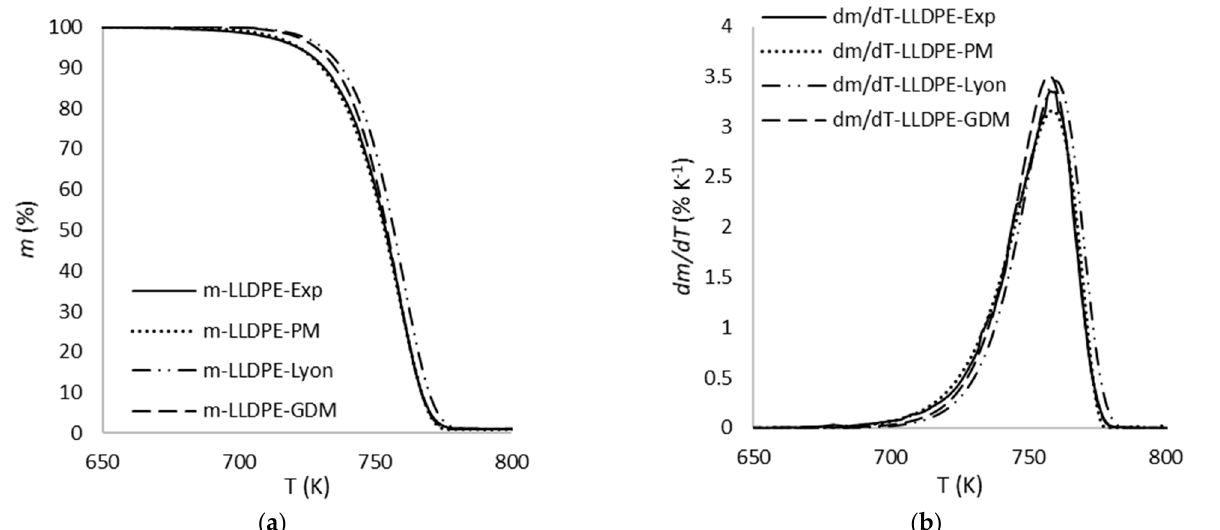
Figure 12. A comparison of experimental and calculated ( a ) mass and ( b ) dm / dT results for